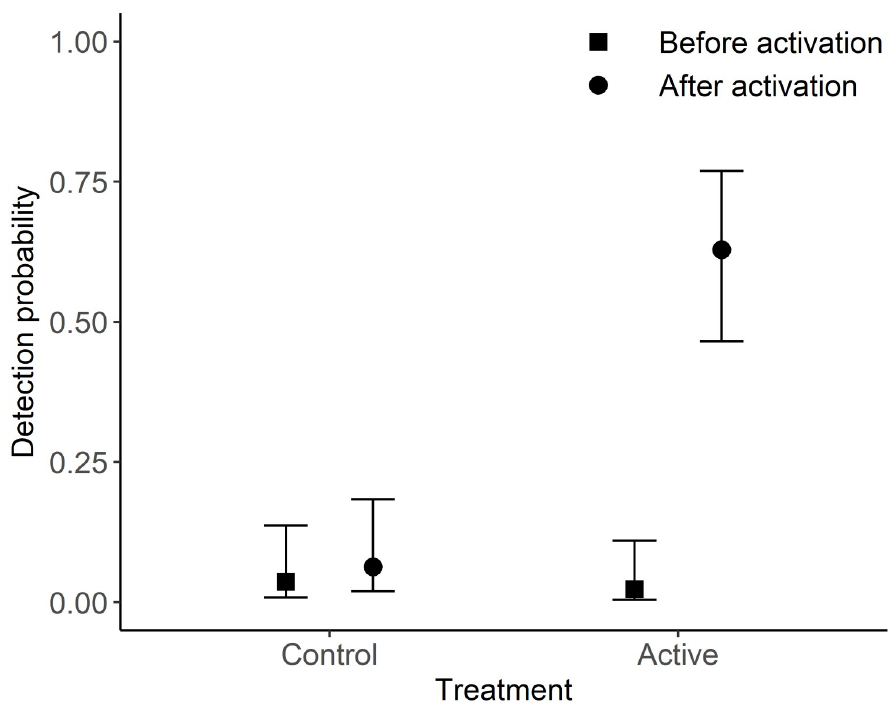
Fig 4. The detectability (mean ± 1.96SE) of stubble quail during pre- and post-transect surveys at both the control (‘quail caller’ inactive) and treatment (‘quail caller’ active) sites.